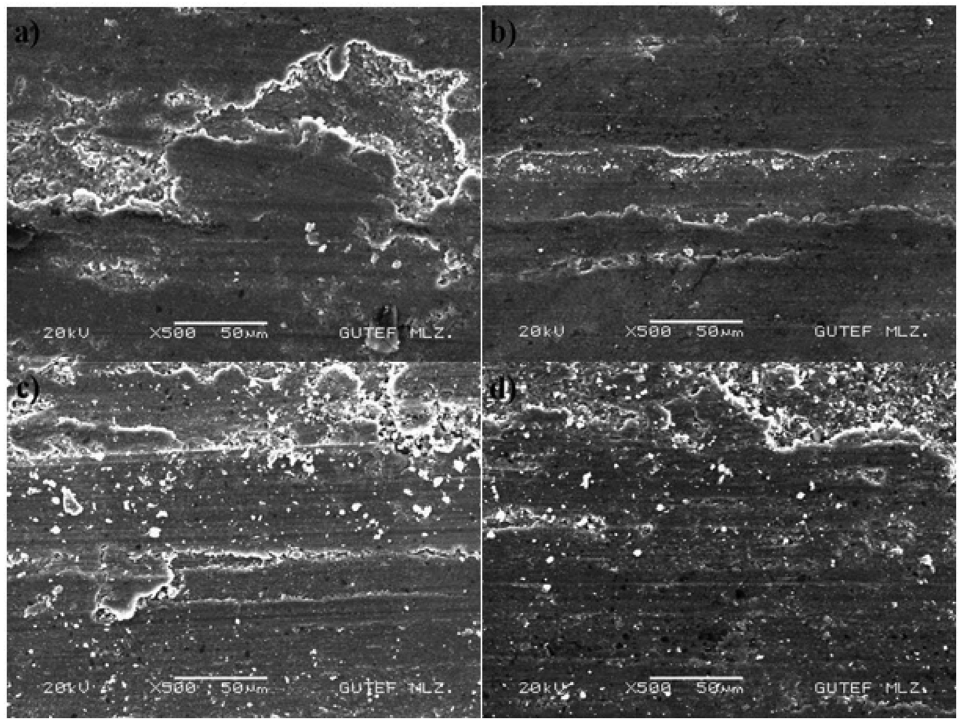
Figure 5: Wear surface SEM images of hybrid composites tested under 30 N load: 4% Ti (a), 4% Ti + 3% B 4 C (b), 4% Ti + 6% B 4 C (c) and 4% Ti + 9% B 4 C